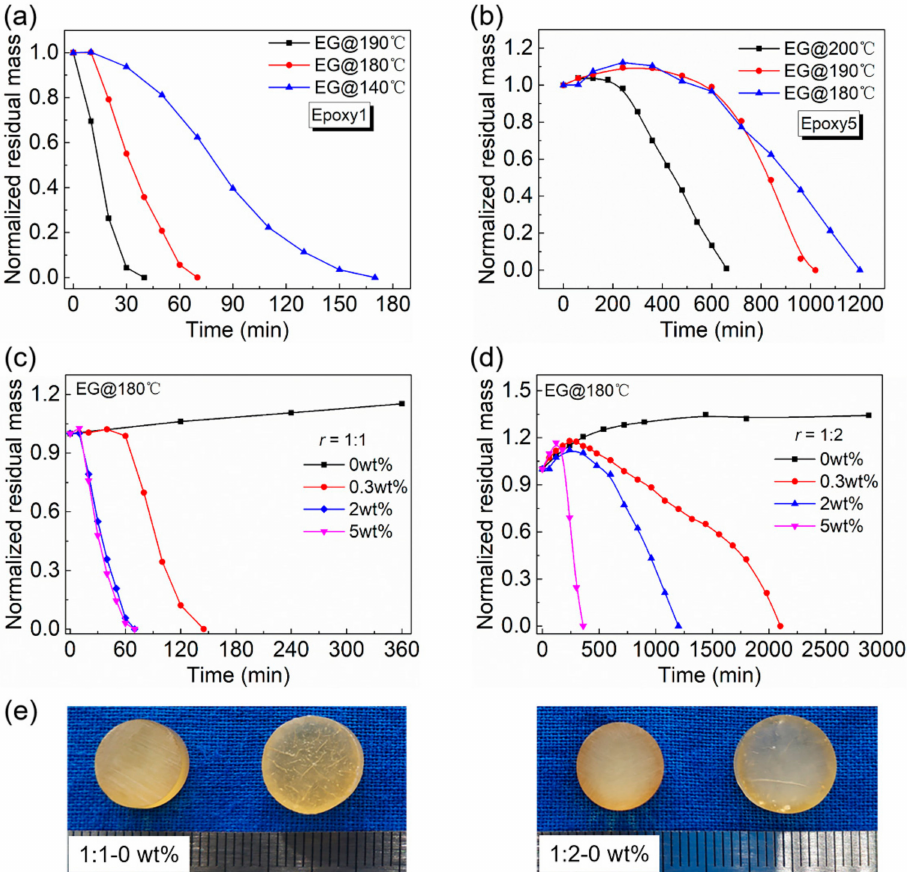
Figure 10. The influence of temperature and DMP-30 content on the dissolution of epoxy resins: ( a ) The normalized residual mass of Epoxy1 as a function of time after immersing in EG at different temperatures; ( b ) The normalized residual mass of Epoxy5 as a function of time after immersing in EG at different temperatures; ( c ) When r = 1:1, the normalized residual mass of epoxy resins with different contents of DMP-30 as a function of time; ( d ) When r = 1:2, the normalized residual mass of epoxy resins with different contents of DMP-30 as a function of time; ( e ) The appearance and size changes of samples without DMP-30 after being soaked in EG at 180 ◦ C for 48